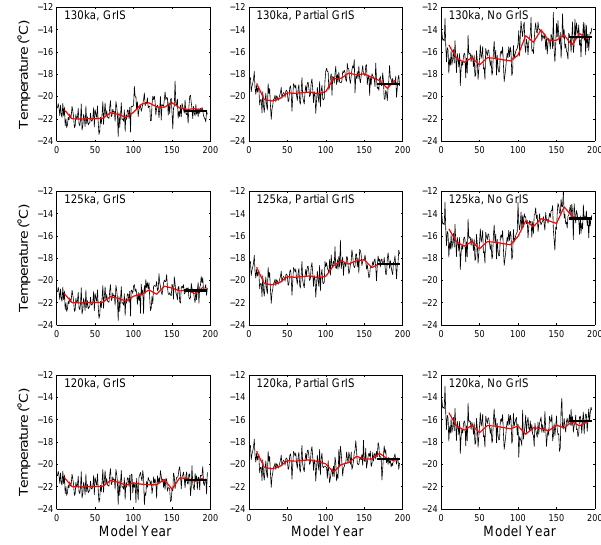
Fig. 3. Near-surface HadCM3 Greenland temperature time series for the three LIG snapshots with a GrIS, partial GrIS and without a GrIS included. The first 100yr represent pre-industrial greenhouse gases and orbital conditions. The last 100yr are the temperature re- sponse to changed orbital parameters. The black line is the annual mean and the red line is the 10-yr mean. The thick black horizon- tal line shows the 30-yr annual Greenland temperature average re- quired to force the ice sheet